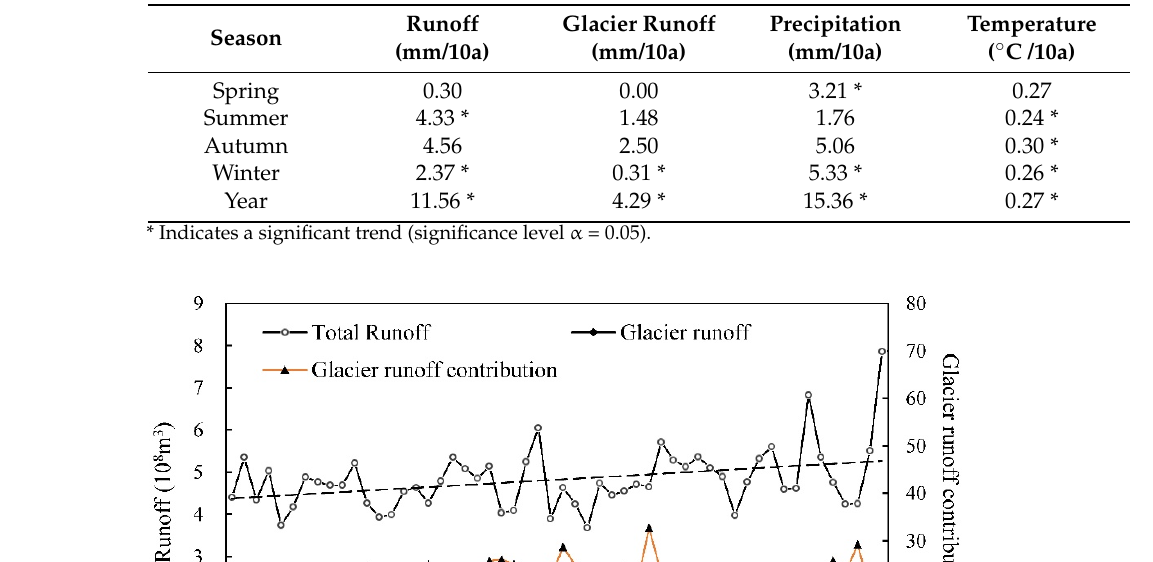
Table 4. The changing characteristics of hydrometeorological elements in a seasonal scale.